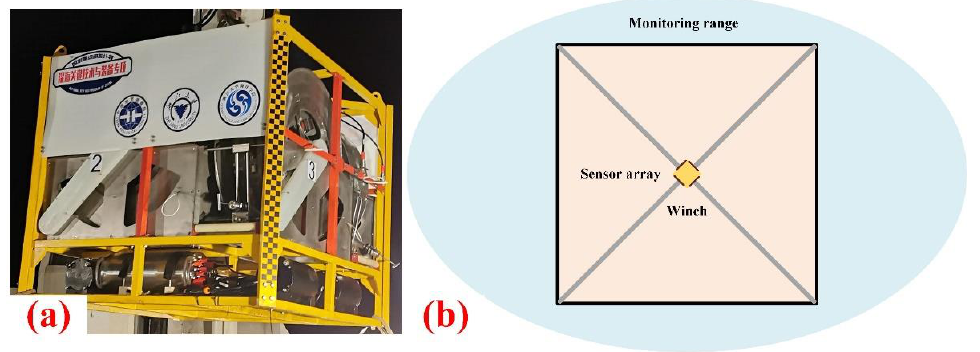
Figure 3. ( a ) Underwater winch; ( b ) Monitoring